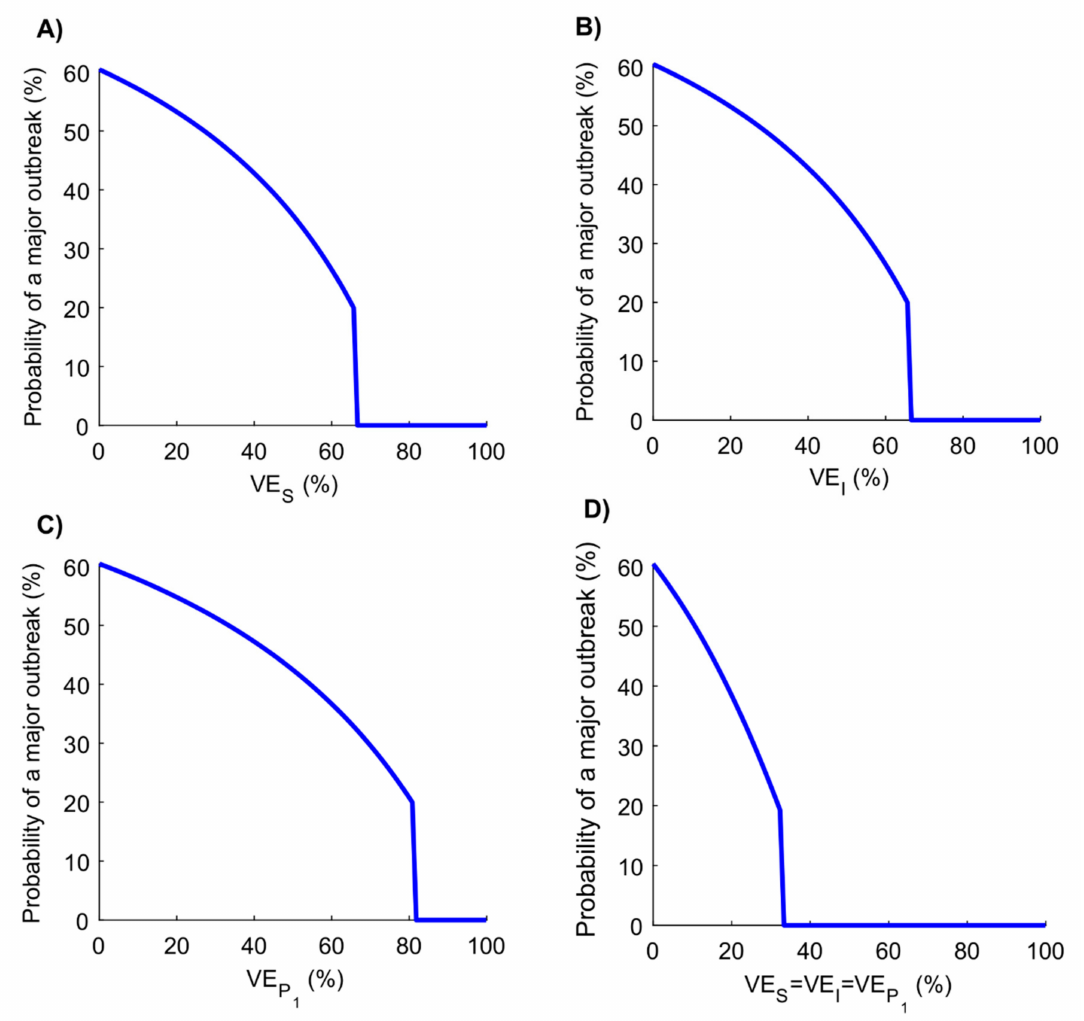
Figure 7. Probability of occurrence of a major outbreak following vaccination. Probability of occurrence of a major outbreak upon virus introduction at varying levels of ( A ) VE S , ( B ) VE I , ( C ) VE P ( D ) VE S = VE I = VE P . Scenario assumes vaccine scale-up to 80% coverage before epidemic 1